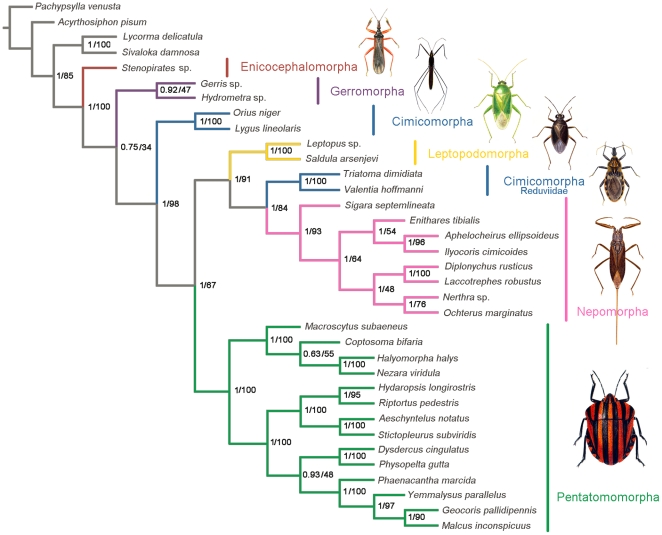
Phylogenetic relationships among the sequenced true bugs.Phylogenetic analyses were carried out for the 31 true bugs based on all 13 protein-coding genes from their respective mt genomes. The tree was rooted with four outgroups (P. venusta, A. pisum, S. damnosa and L. delicatula). Numbers at the nodes are Bayesian posterior probabilities (left) and ML bootstrap values (right).